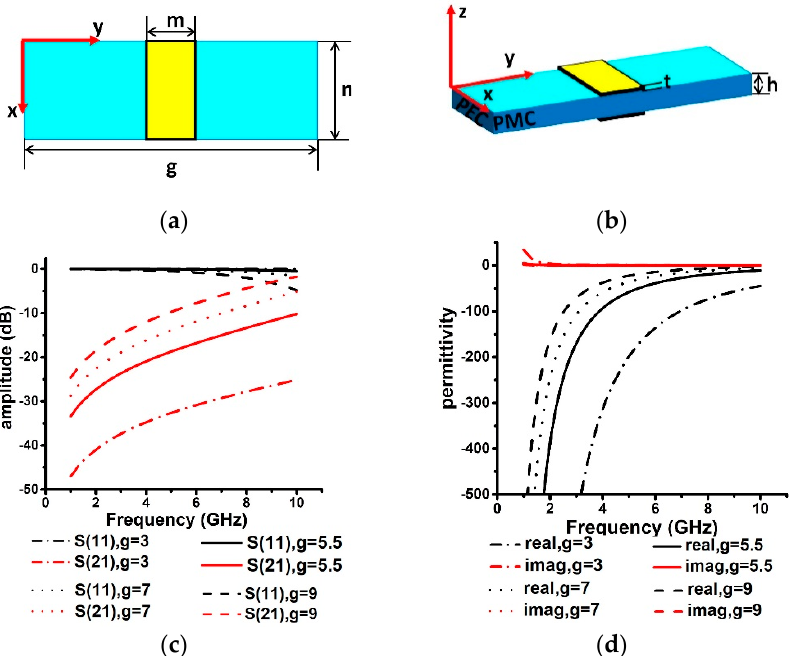
Figure 1. Structure and EM properties of linear-type metamaterials unit: ( a ) top view; ( b ) side view; ( c ) S11 and S21; ( d ) permittivity.